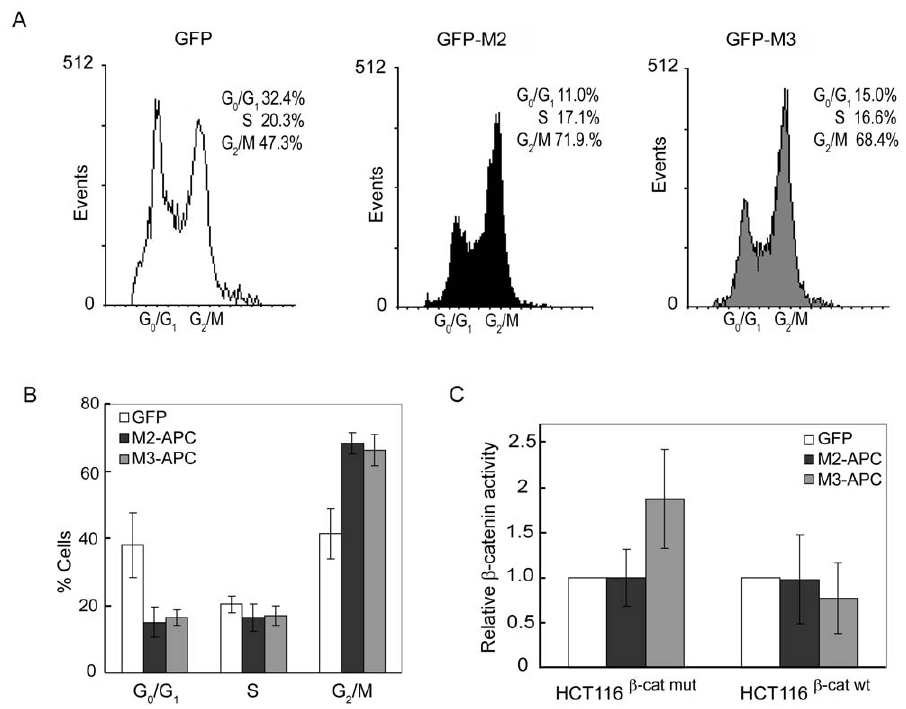
Figure 6. Mutant b -catenin does not compromise the ability of M2- or M3-APC to trigger G2 cell cycle arrest. (A) HCT116 b m cells that express only stabilized b -catenin show accumulation in G2/M when expressing M2- or M3-APC. Histograms showing representative FACS displays of cell cycle distribution assessed by Hoechst blue staining at 48 hours post-transfection. Only EGFP-positive cells are displayed. (B) Bar graphs show FACS-based cell cycle distribution from three independent experiments. Error bars represent standard deviation. When compared to cells expressing only EGFP, by 48 hours post-transfection, the fraction of M2 or M3-APC expressing cells in G2/M increased by 1.7-and 1.6-fold, respectively. (C) Expression of M2-APC does not alter b -catenin activity in HCT116 b w ( b -cat wt) or HCT116 b m ( b -cat mut) cells; however, expression of M3-APC leads to distinct changes of b -catenin activity in the two cell lines. Luciferase activities were determined 48 hours post-transfection and activity of the b - catenin reporter construct (TOP-flash) was normalized against both pRL-TK Renilla activity and FOP-flash reporter activity. p values for HCT116 b m ( b - cat mut) cells are p=0.50 (M2) and p=0.03 (M3); and for HCT116 b w ( b -cat wt) cells are p=0.49 (M2) and p=0.39 (M3). Values are presented as average 6 standard deviation for triplicate samples from three independent